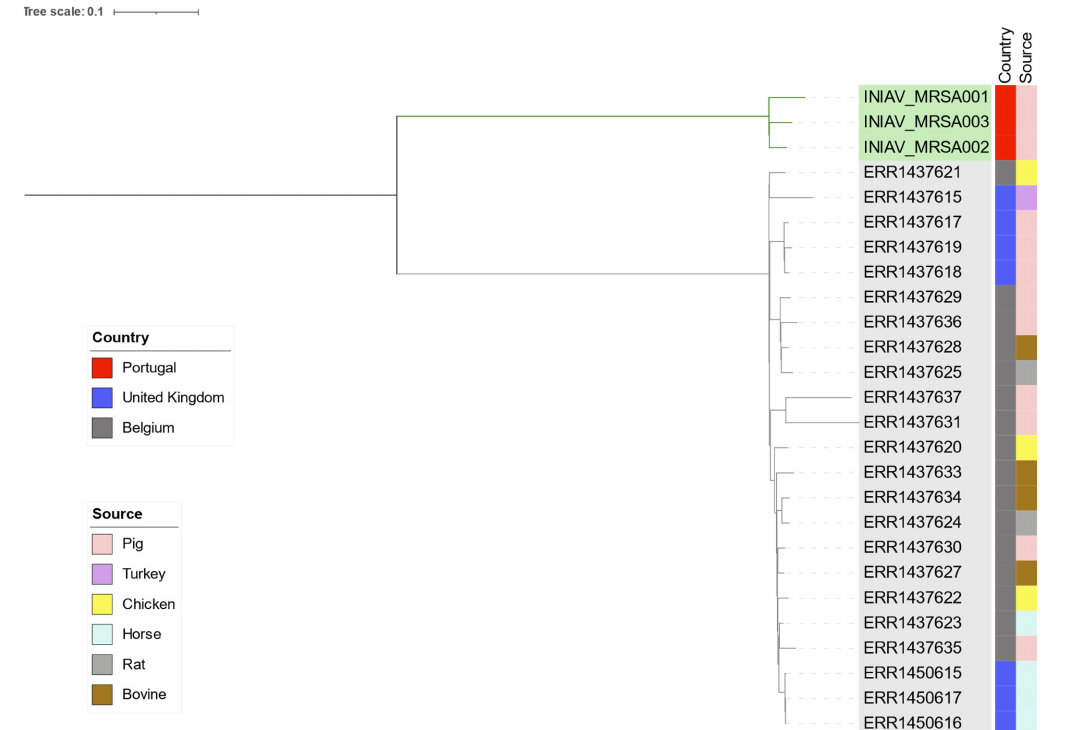
Figure 5. Phylogenetic analysis based on core genome single-nucleotide polymorphisms (SNPs) using CSI Phylogeny v.1.4 of 26 MRSA ST398, t011 strains from multiple sources and different countries. Graphic representation using the iTol interactive tree of life, showing the geographic location, source, and genetic distance of the isolates. In green are the isolates from this study. ERR*******, accession numbers of the strains used in this